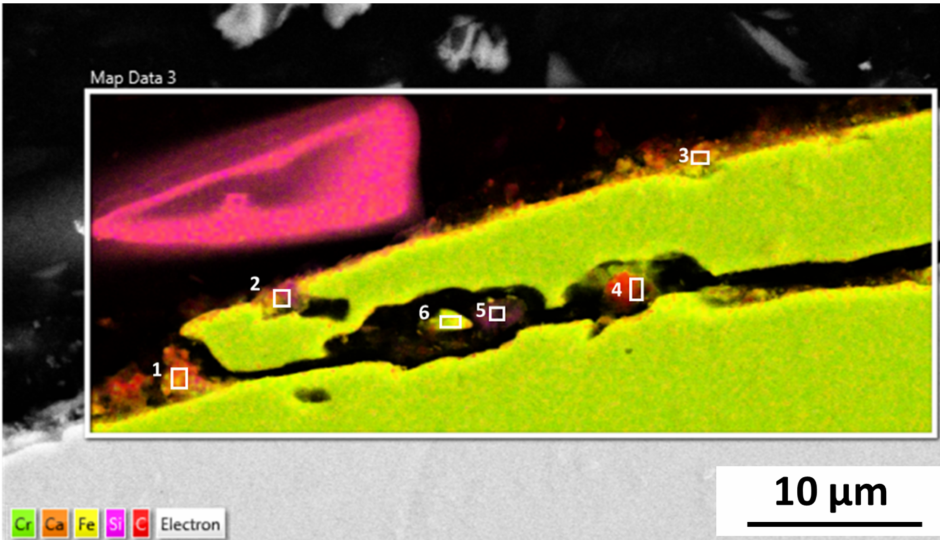
Figure 17. Element mapping and analysis of 254SMO after being exposed in Chaunoy. Within the crack there is visible inclusion of Al and Si, number 5. Furthermore, there is corrosion deposit in locations number 1, 2, and 3, containing S and elements from the base material, Cr, Fe, and Ni. The colour map shows the relative chemical composition of Cr, Ca, Fe, Si and C in the